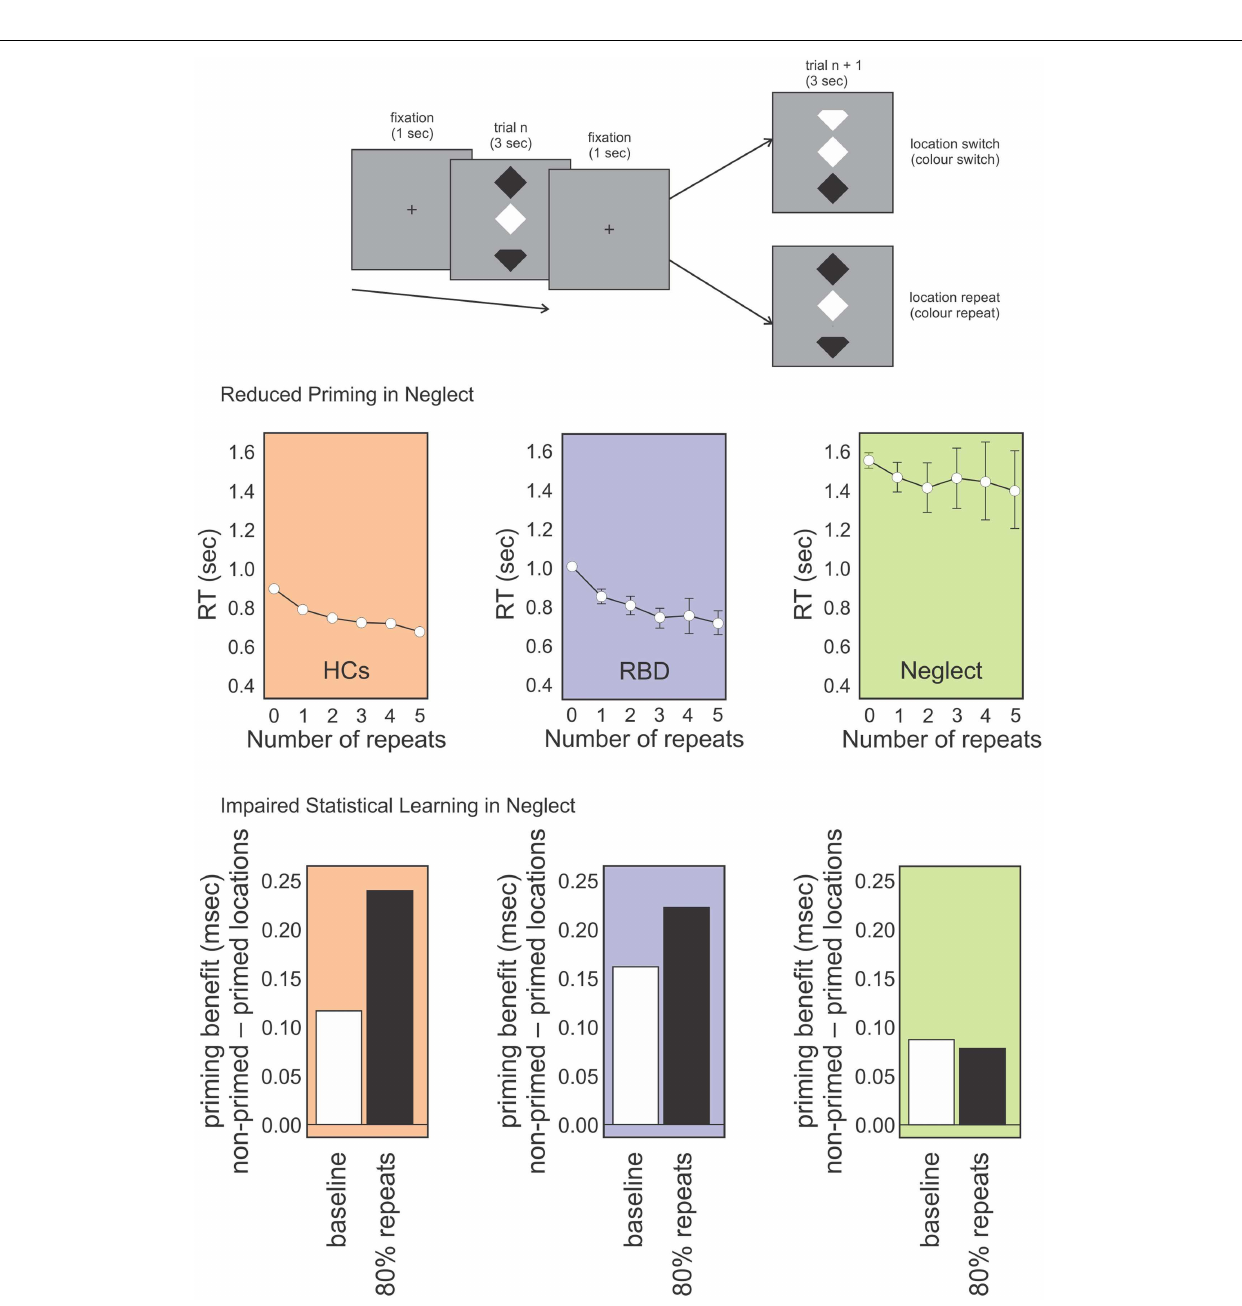
FIGURE 2 |Topmost panel: schematic representation of our position priming task (Shaqiri andAnderson, under review) . Participants were required to detect if the top or bottom notch of the odd-colored diamond was missing (the schematic here exaggerates the actual physical distinction). Middle panel: RT data for healthy controls (HCs; orange panel), RBD patients (purple panel), and Neglect patients (green panel) for targets that repeated spatial locations on subsequent trials (up to five repeats). RBD patients show